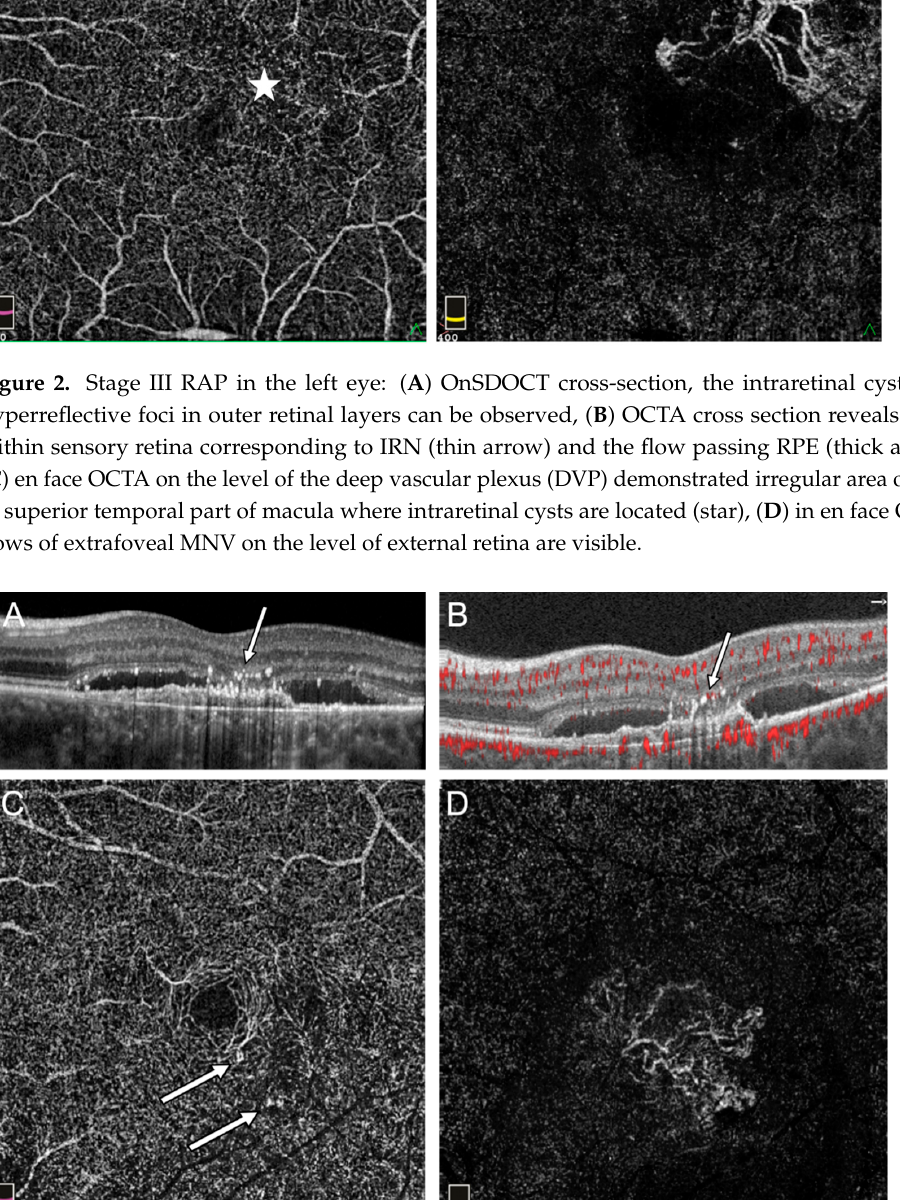
Figure 4. Fourfold display for presence of cysts and ( A ) IRN, ( B ) RCA. The area of each quadrant is proportional to the cell frequency. Circular arcs show the limits of a 95% confidence interval for the odds ratio in logarithmic scale. In Group 1, vascular flow on OCTA within the SVP and especially the DVP on en face imaging was characterized by the appearance of areas devoid of vessels where flu- id-filled cysts were present. The mean vessel density of the SVP over the entire meas- urement area in Groups 1 and 2 were 43.11 ± 5.99% and 46.91 ± 5.20%, respectively ( p <